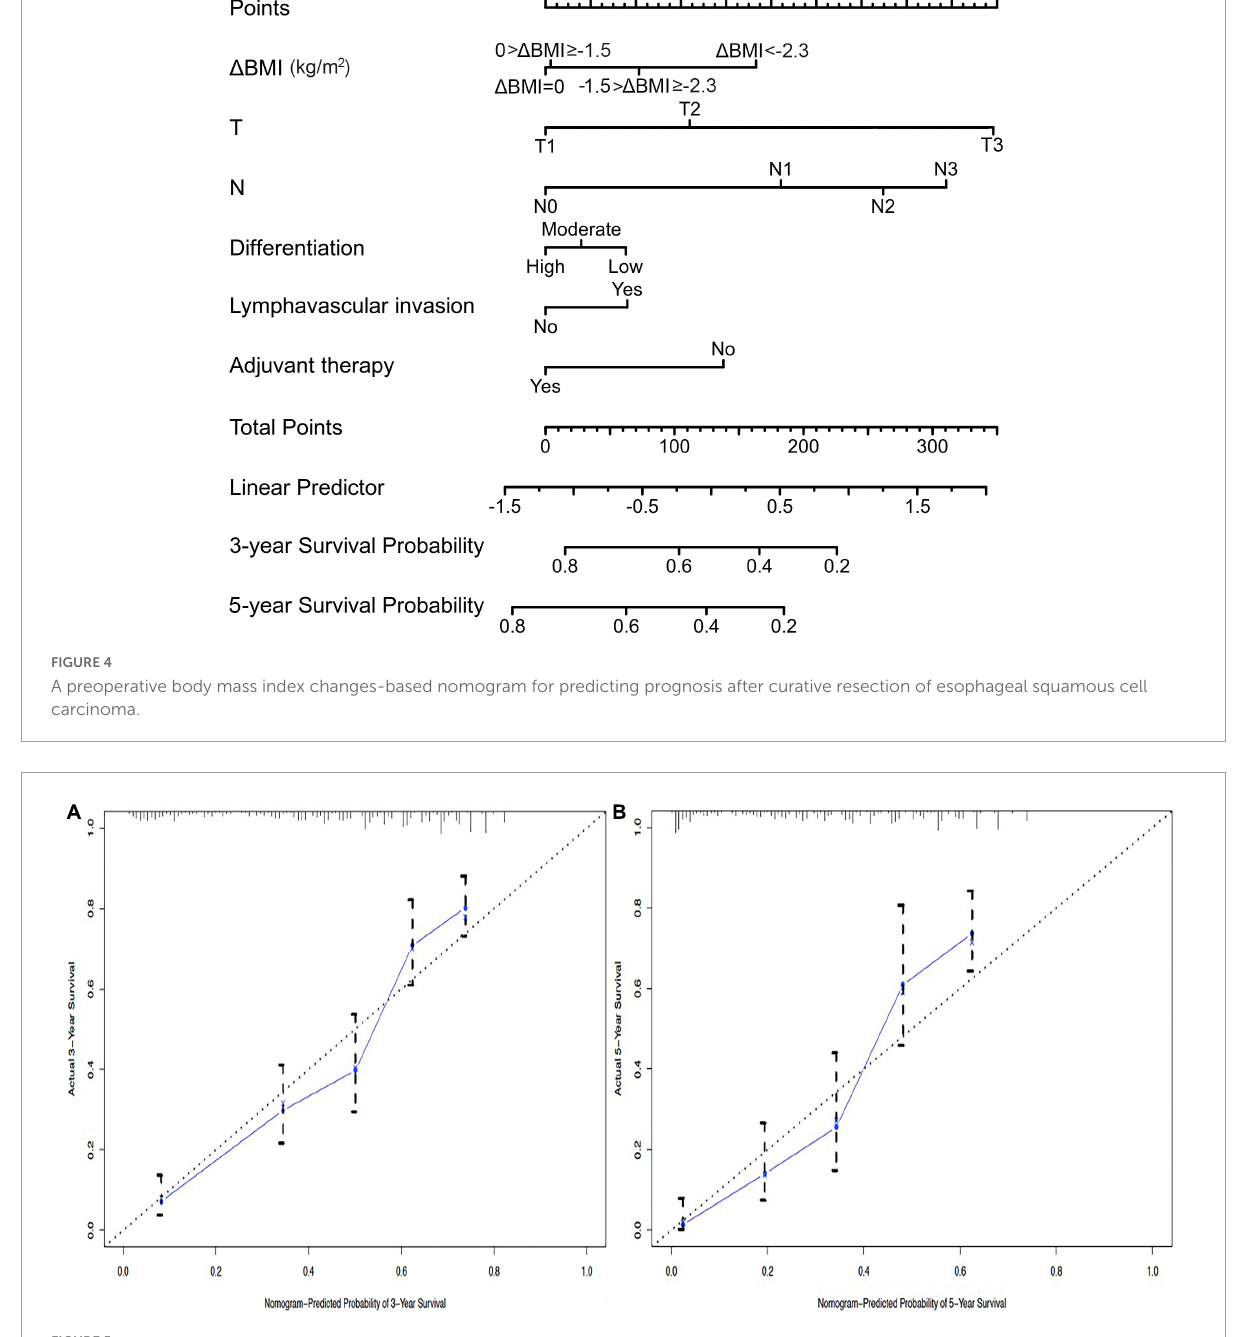
FIGURE5 Calibration curves of the nomogram to predict 3-year overall survival (A) and 5-year overall survival (B)